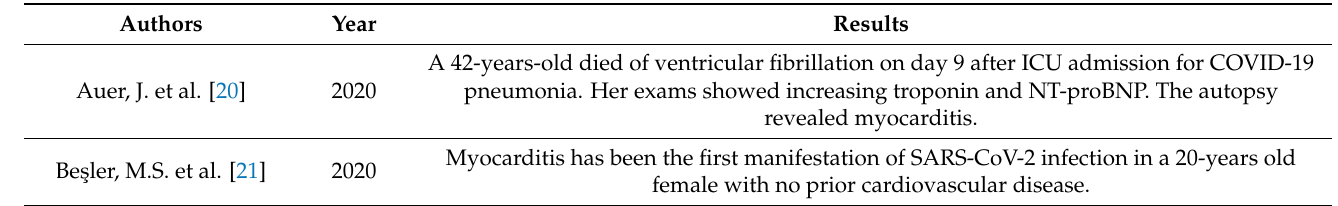
Table 1. Inflammatory cardiomyopathies and